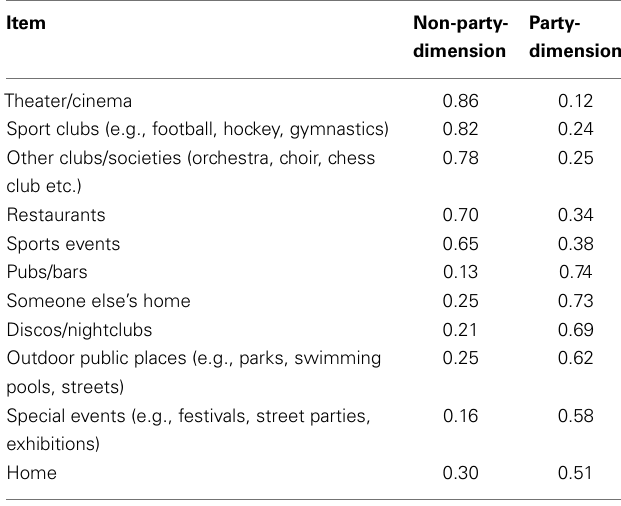
Table 1 | Principal component analysis on drinking locations with varimax-rotated factor solutions ( n = 2696)